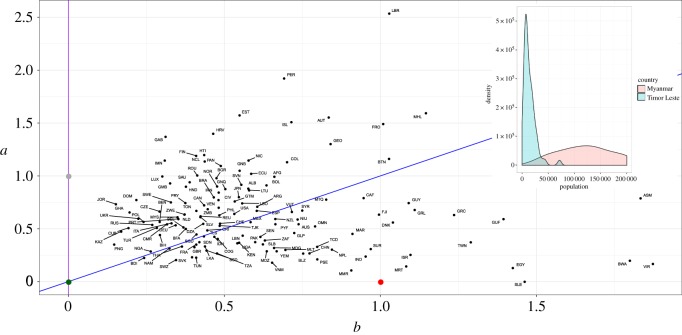
Scatter plot of fitted b and a for the 141 selected countries. Each country is indicated by its three-letter ISO3 code. The purple line corresponds to b=0, which represents a perfect power law; the blue line denotes b=a, which is the Lavalette rank-size function; the grey point is (0,1), a pure Zipf’s law; green is (0,0), representing a point-located probability distribution; and the red point is (1,0), corresponding to a random uniform distribution. We also show the density histograms for two countries: Myanmar, whose parameters indicate a closeness to a random uniform distribution, and Timor Leste, whose parameters suggest a distribution similar to a very narrow lognormal.